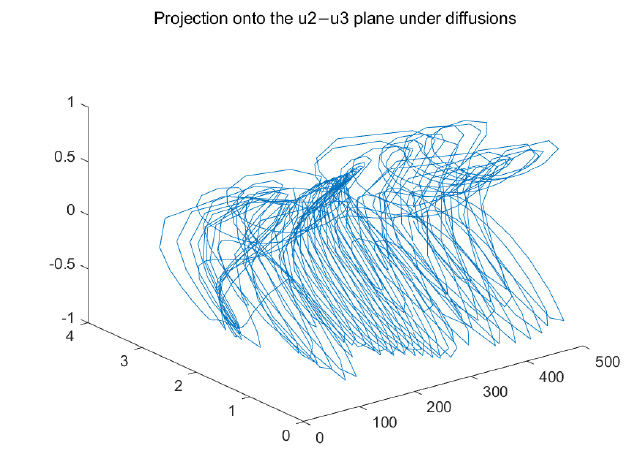
Figure 7. Computer simulations of chaos of financial system under diffusions.